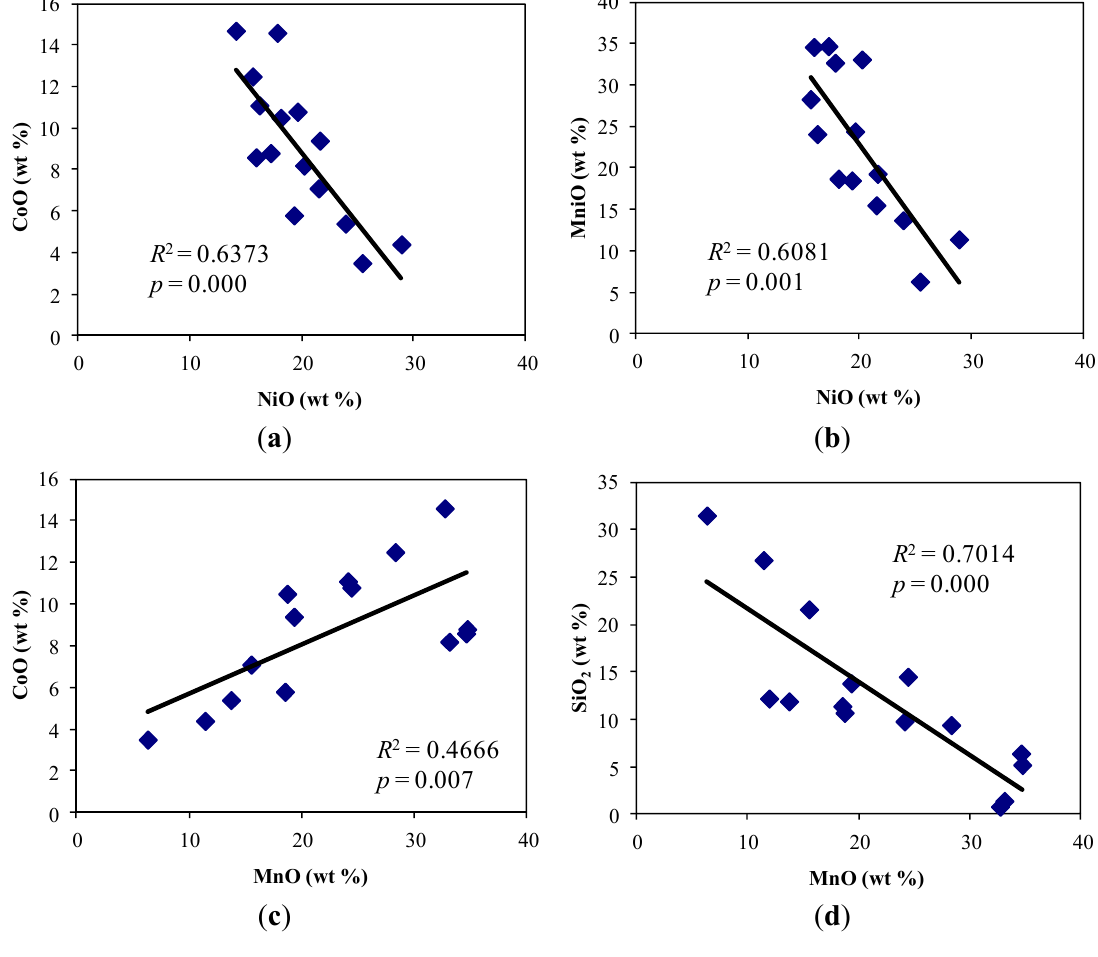
Figure 4. Variation of MnO, CoO, NiO and SiO Mn-Co-Ni-hydr(oxides), with concentric and botryoidal textures (Figure 3j). Representative analyses are given in Table 3. If possible, please redraw these figures and it will be more beautiful than adding lines in